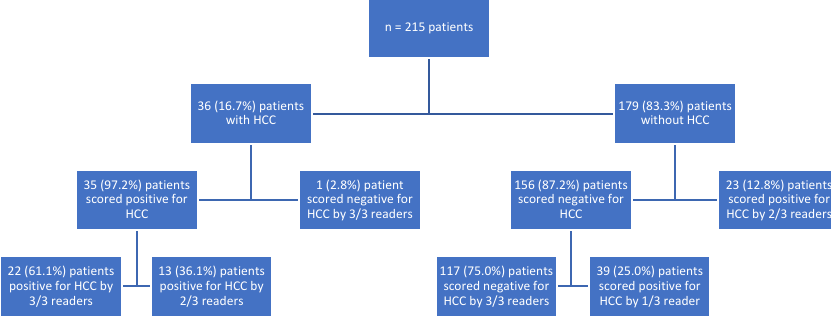
Table 2. Scoring results of the three readers (separate and combined using majority vote) in subgroups with and without HCC in a surveillance population, with statistical analysis.